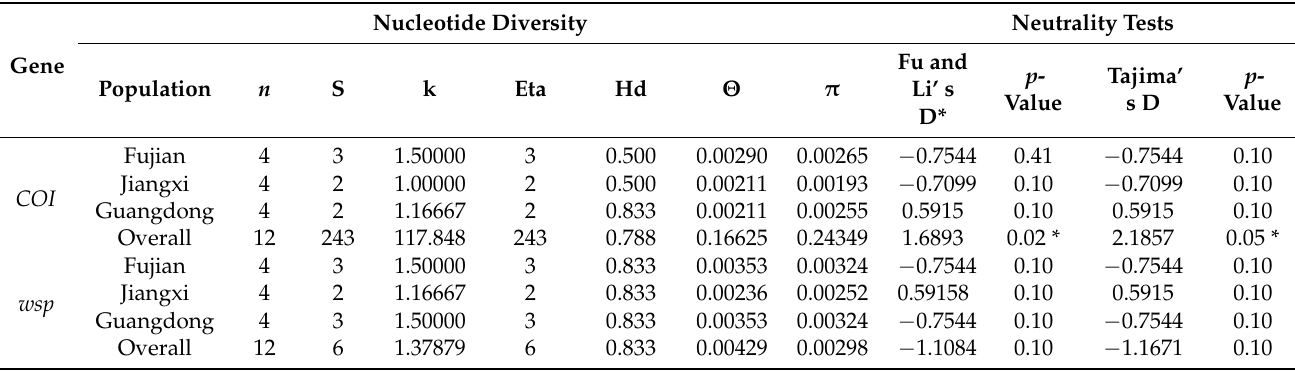
Table 4. Genetic diversity of different populations of Tamarixia radiata calculated via nucleotides polymorphism data